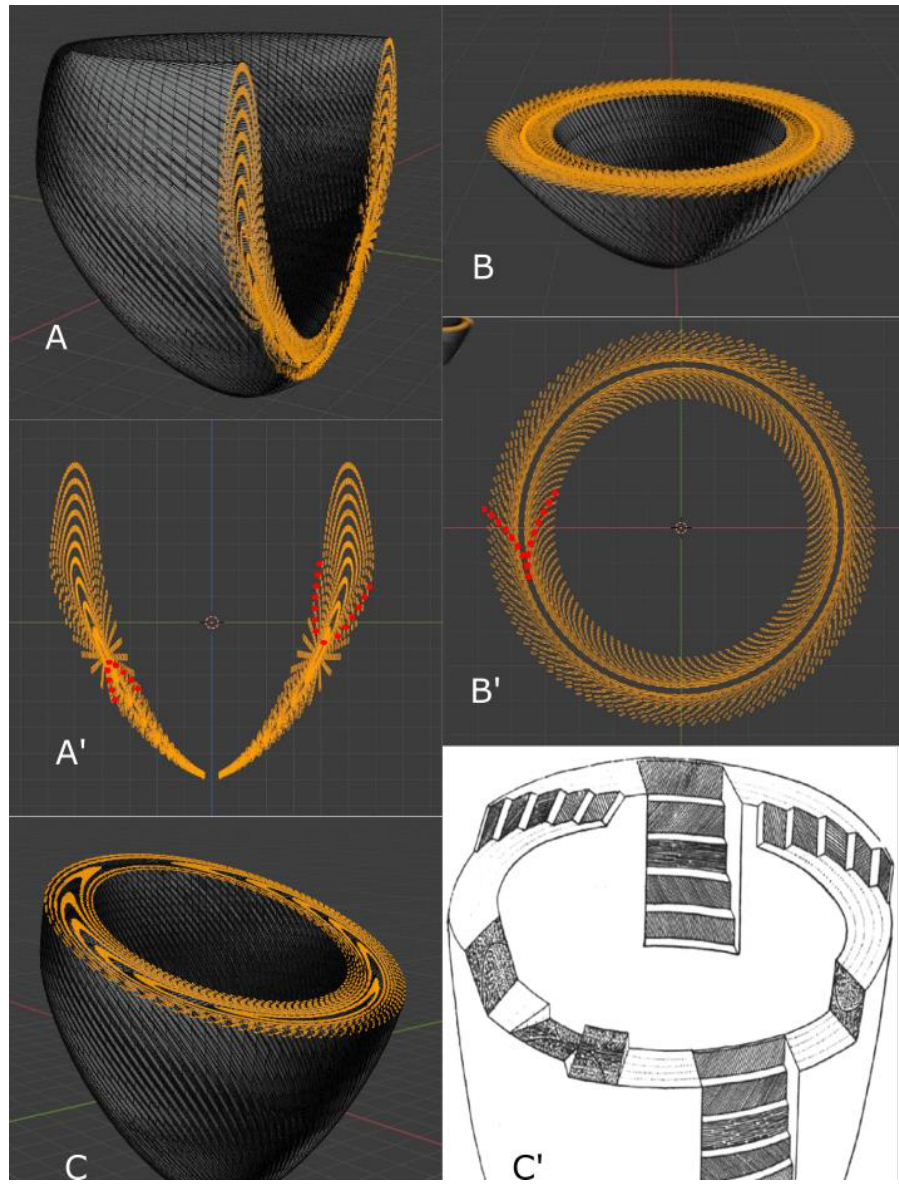
Figure 9. ( A ) Parasagittal section of a set of ten nested tori, each covered by a hundred geodesics. ( A’ ) Sagittal slice: Each orange point represents the section of one geodesic. Two ordered series of contiguous orange points draw discontinuous lines: on one are the ortholines that draw the contours of the nested tori and on the other are the paralines that connect the closest neighbouring points between different tori. Two paralines are coloured red to highlight the different orientation of their concavities on either side of the equator. ( B ) Near apical section of the same set of nested tori. ( B’ ) Short axis horizontal slice. The ortholines are difficult to identify, with the exception of the two medial wall ortholines that correspond to the inner and outer wall of the deepest nested torus. The paralines describe chevron-shaped patterns, with one coloured in red ( C ) Oblique section: the chevron-shaped patterns vary in their orientation according to their different positions around the revolution axis of this very simplified model of the left ventricle. ( C’ ) Reproduction of a 1943 Feneis sketch. The nested tori model explains the observed variations of the different